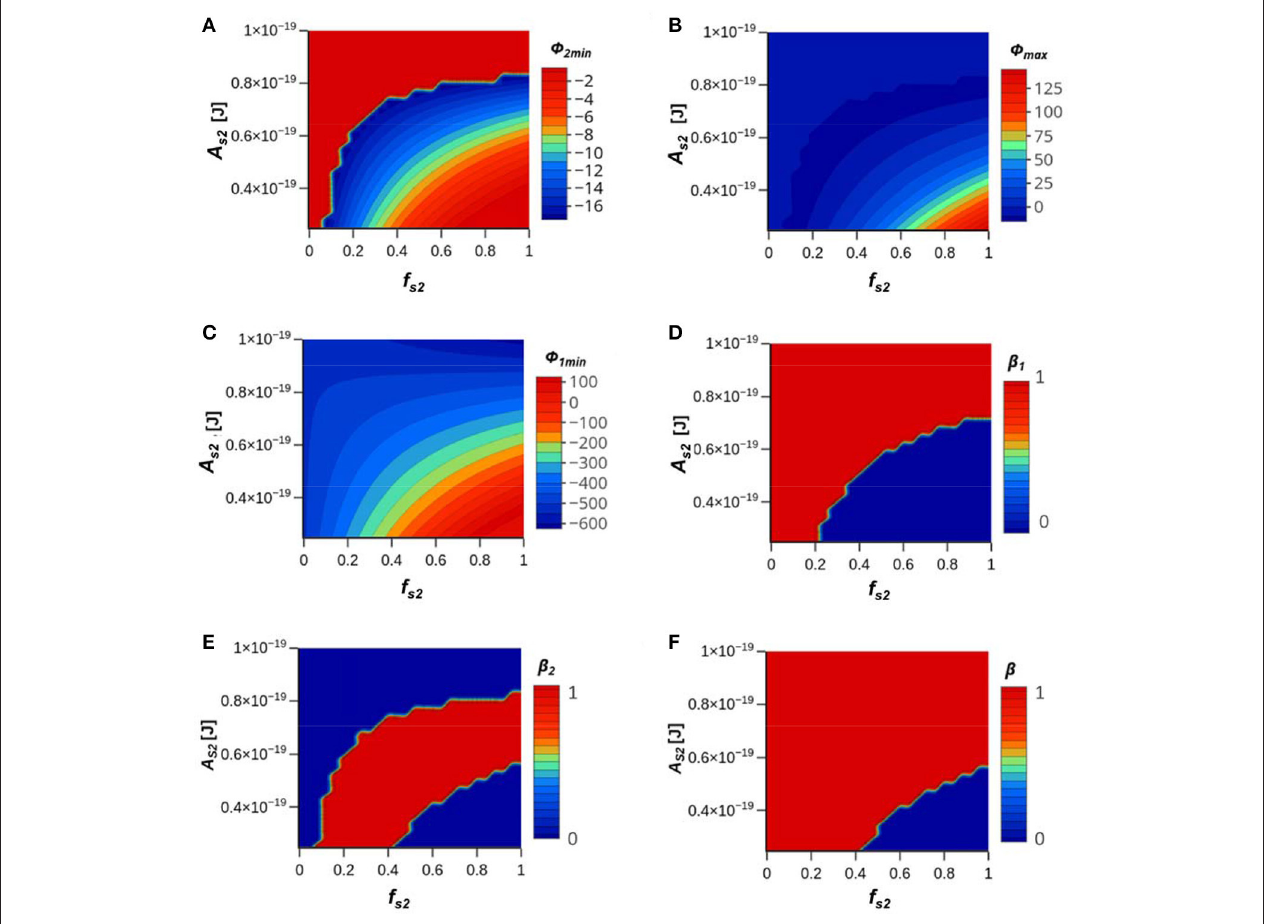
FIGURE 1 | Contour plots of (A) Φ 2min , (B) Φ max , (C) Φ 1min , (D) β 1 , (E) β 2 , and (F) β for a hydrophilic bacterium when the IS the van der Waals interaction was considered. The solid phase Hamaker constant and fraction on site 2 were varied from A s 2 0 to 1. Table 1 gives a summary of all =